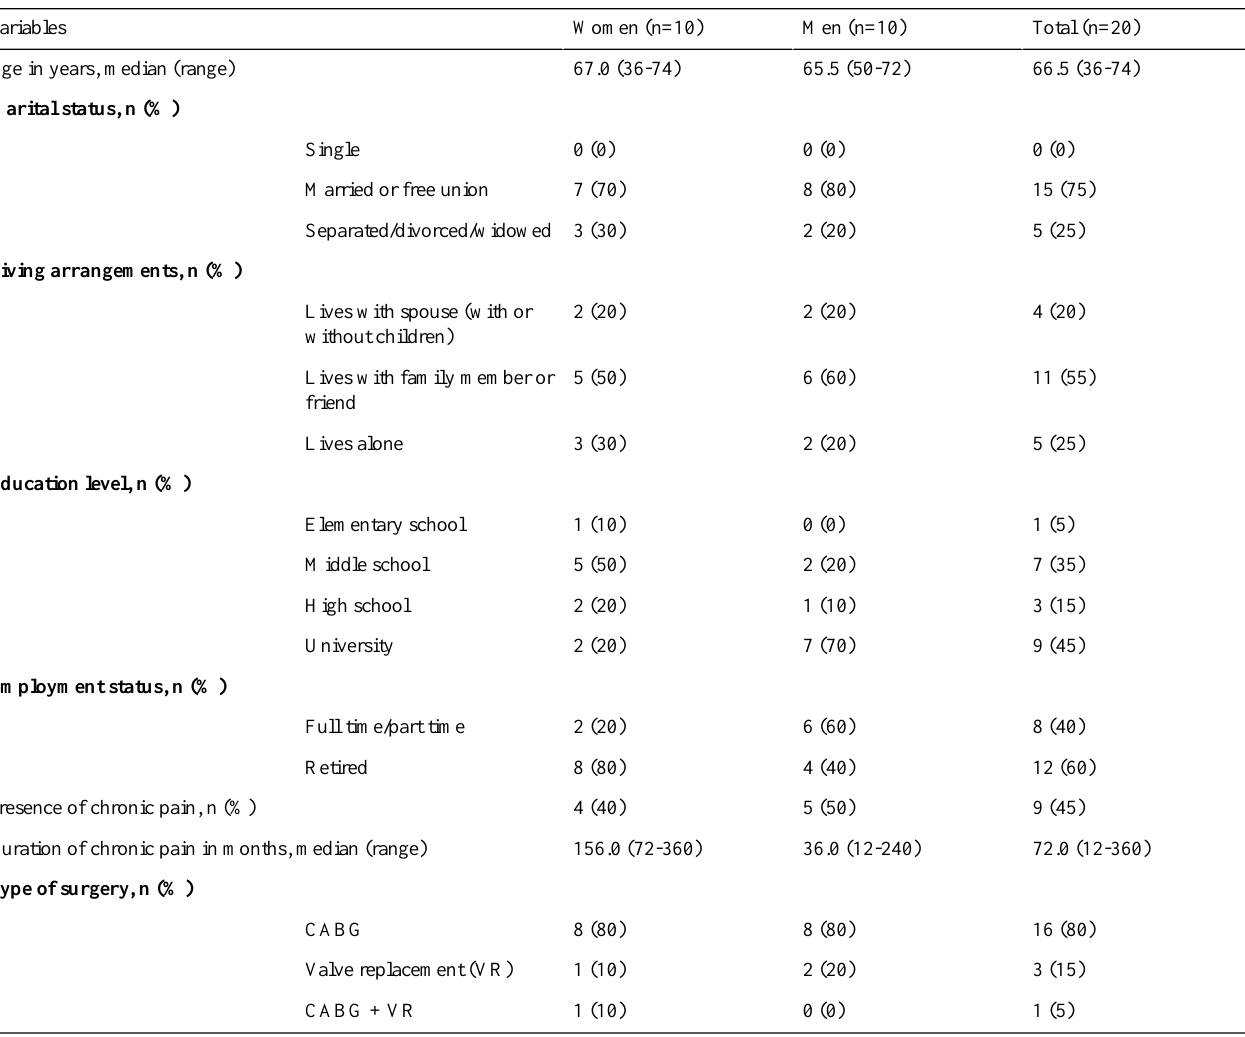
Table 3. Sociodemographic characteristics of